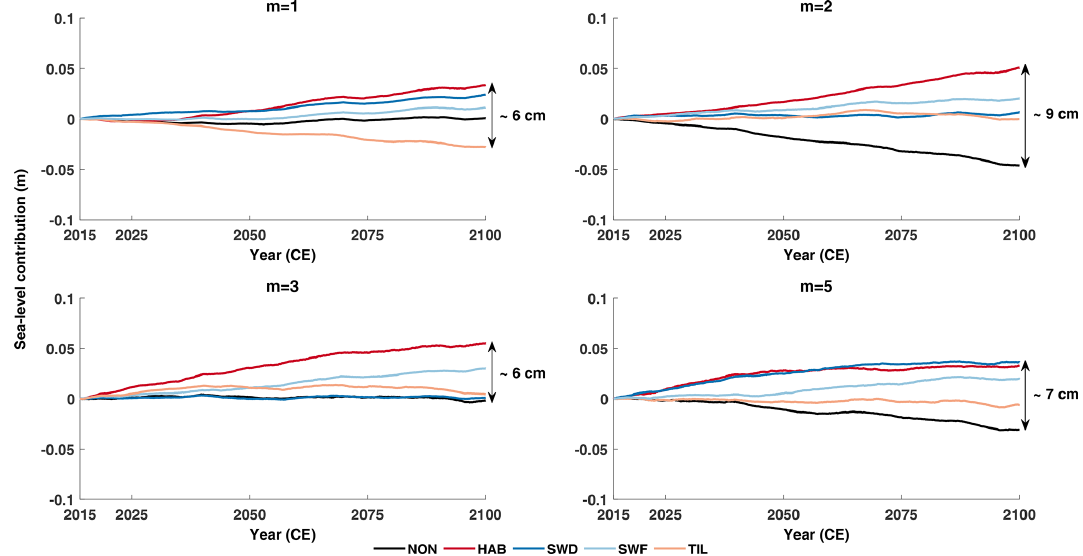
Figure 6. Sea level contribution from the Antarctic ice sheet until 2100 following NorESM1 in the RCP2.6 scenario. Each graph gives the results for one exponent of the basal sliding law, and line colours represent the different subglacial models (Table 2).